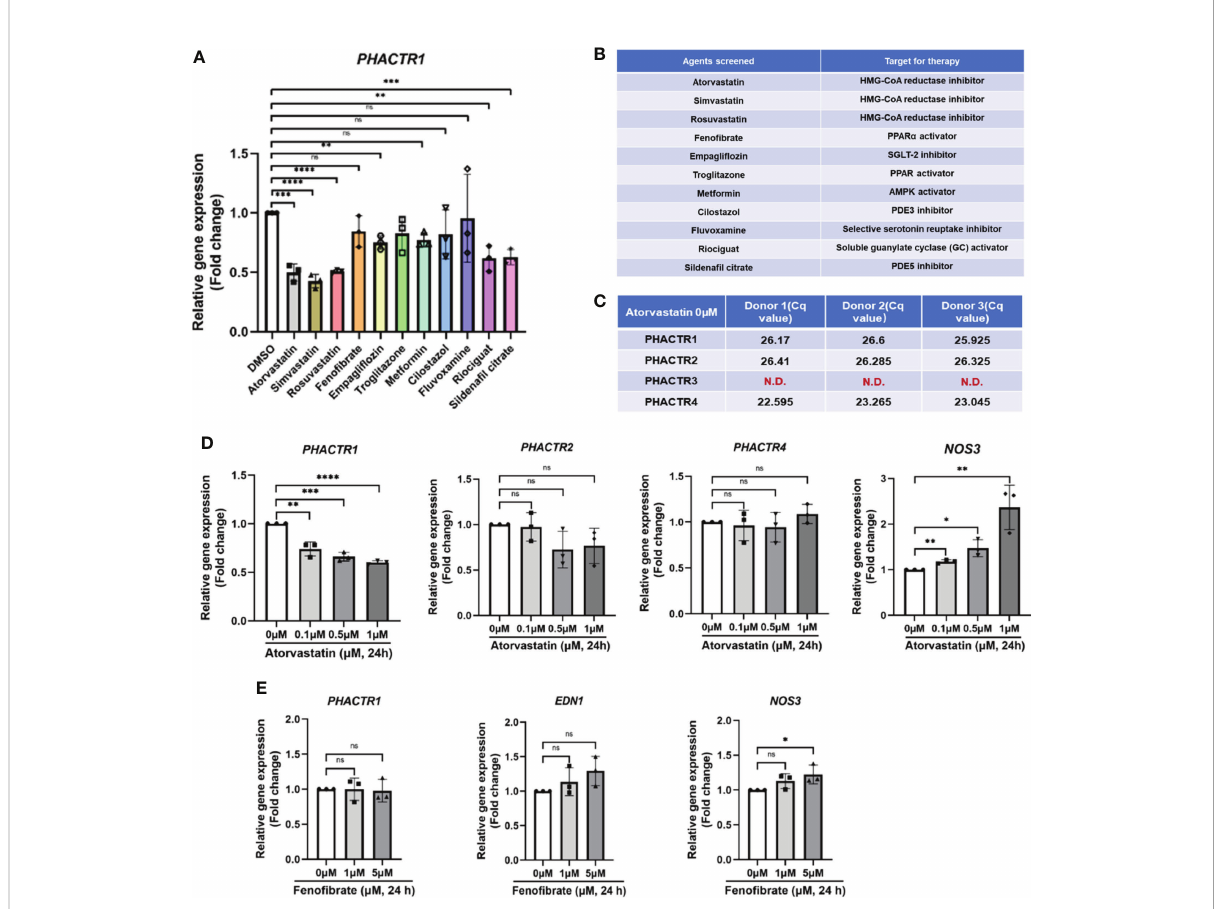
FIGURE 4 Identi fi cation of statin as a negative regulator of PHACTR1 gene expression. (A) Effect of selected 11 compounds in in-house library on PHACTR1 gene expression (n = 3). (B) Compound list and their molecular targets. (C) Gene expression of all PHACTR family members (PHACTR1 to PHACTR4) in HUVECs by real-time PCR (n = 3). (D) Effect of atorvastatin on PHACTR1-4 gene expression in HUVECs. NOS3 (eNOS) was used as the positive control (n = 3). (E) Effect of Feno fi brate on PHACTR1 gene expression in HUVECs (n = 3). ns, non-signi fi cant, N.D.,